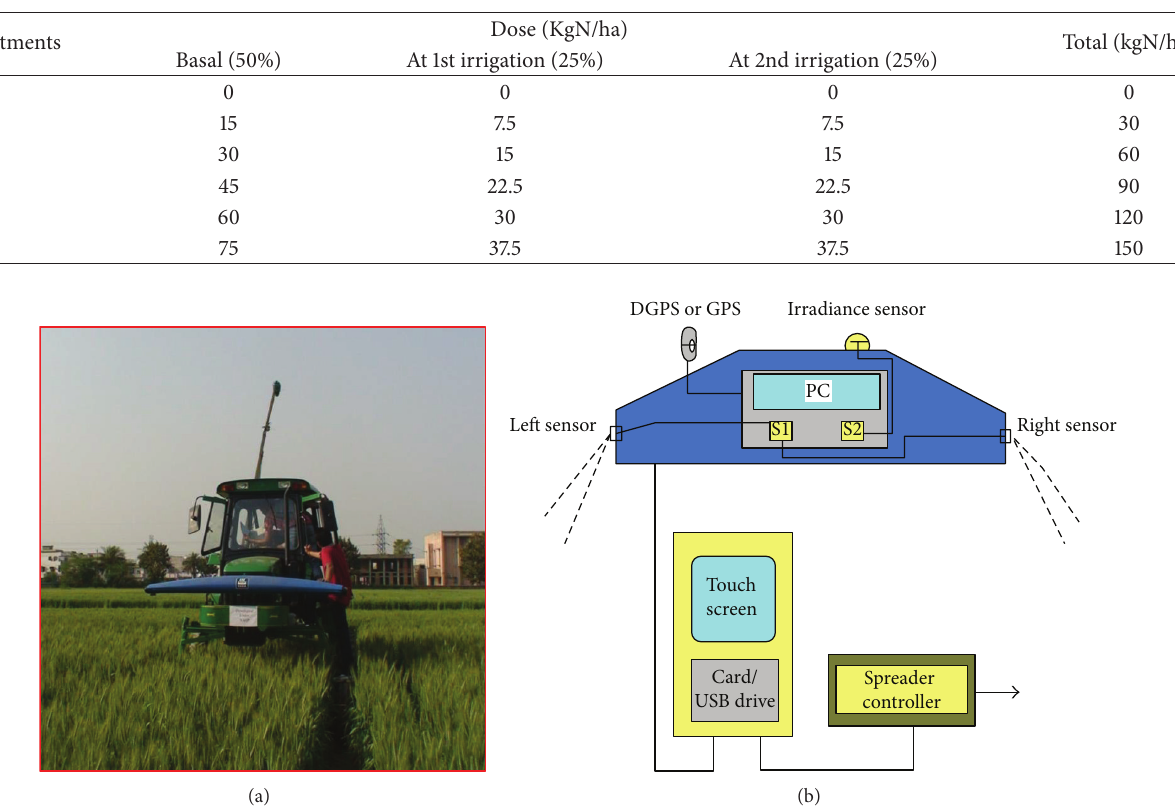
Table 1: Fertilizer in form of urea application timings and doses.